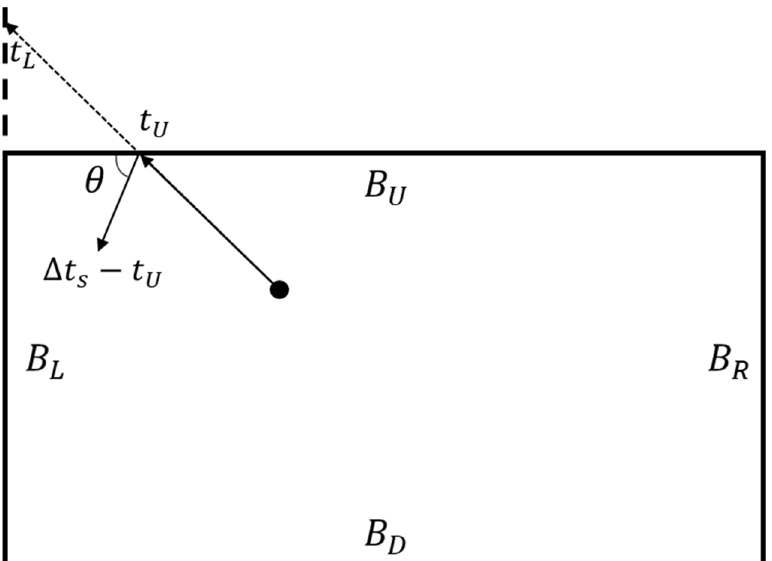
Figure 2. A representation of the ray-tracing method.